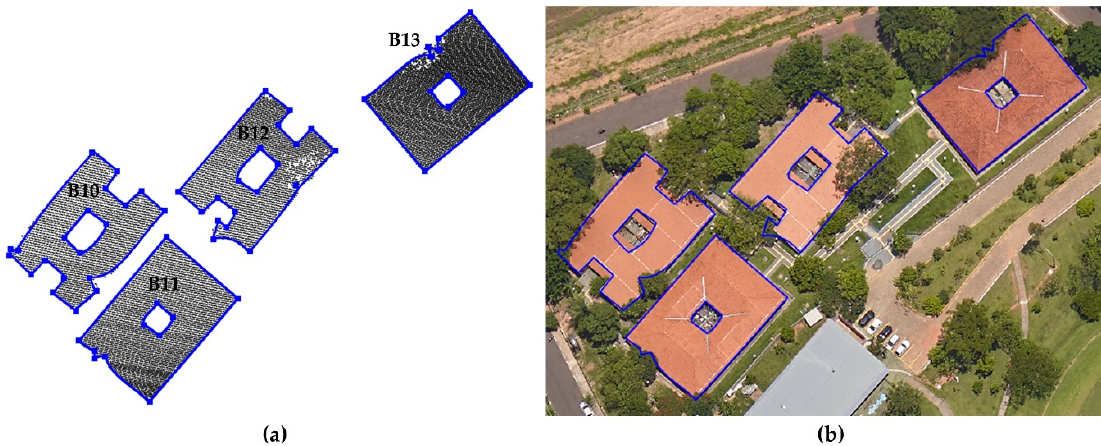
Figure 16. Buildings with vegetation in their surroundings. Boundary regularization using the proposed method over the LiDAR data ( a ) and corresponding aerial image ( b ).